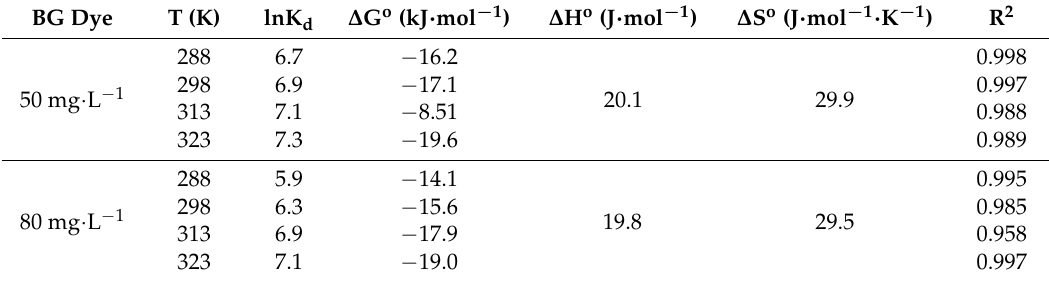
Figure 12. Thermodynamic adsorption for 50 and 80 mg · L − 1 BG dye removal on 0.9 g · L − 1 Hap/CS nanocomposite. Table 3. Thermodynamic data for the adsorption of BG dye onto Hap/CS nanocomposite.